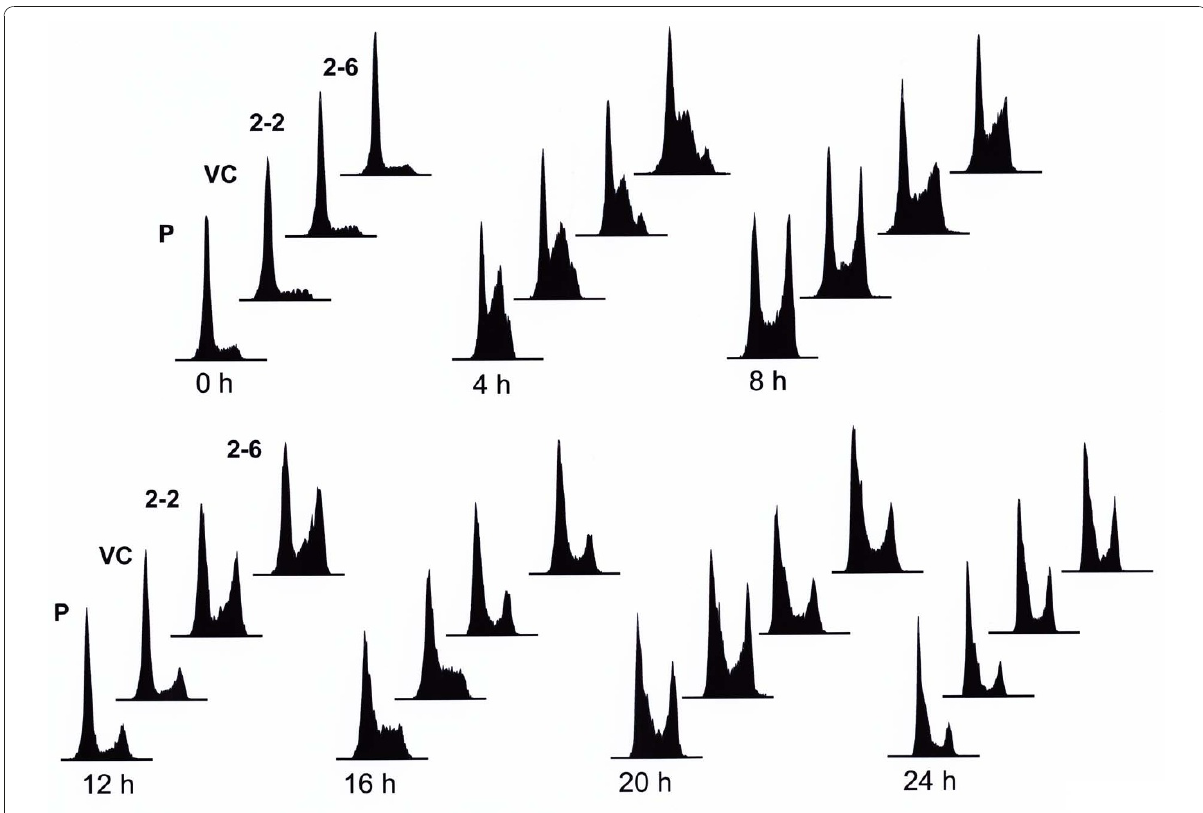
Figure 3 Reducing the level of hRev7 in human fibroblasts results in a BPDE-induced delay in progression through the cell cycle . Cell strains with reduced levels of hRev7 (2-2 and 2-6), their parental cell strain (P), and a vector control transfectant (VC) were synchronized at the G1/S border and treated with BPDE for one h immediately after release from synchrony. Cells were harvested, fixed, and stained with propidium iodide for analysis of DNA content by flow cytometry. The distribution of cells in each phase in the cell cycle 0 h, 4 h, 8 h, 12 h, 16 h, 20 h, and 24 h post-BPDE treatment are